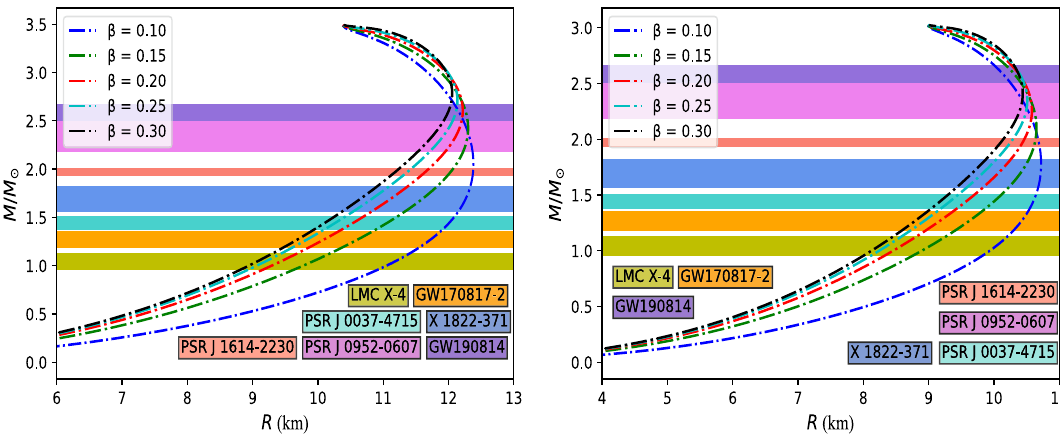
Fig. 10 The variation of Mass ( M / M (cid:8) ) versus Radius ( R ) for solution 5.2, left panel for ρ s (cid:12) 6 × 10 14 gm / cm 3 and right panel for ρ s (cid:12) 8 × 10 14 gm / cm